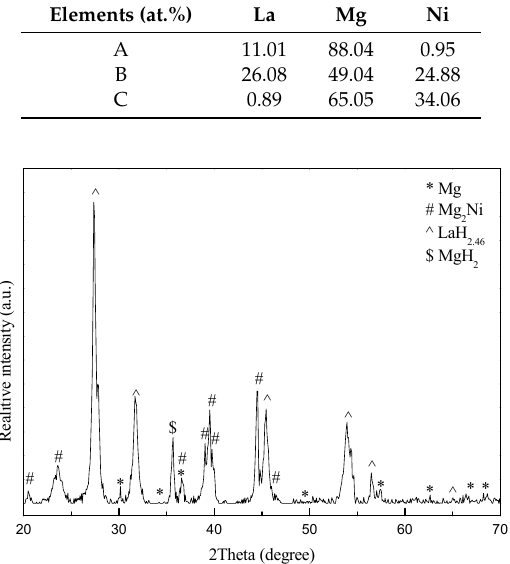
Figure 3. XRD pattern of the dehydrogenated La 7.0 Mg 75.5 Ni 17.5 alloy.